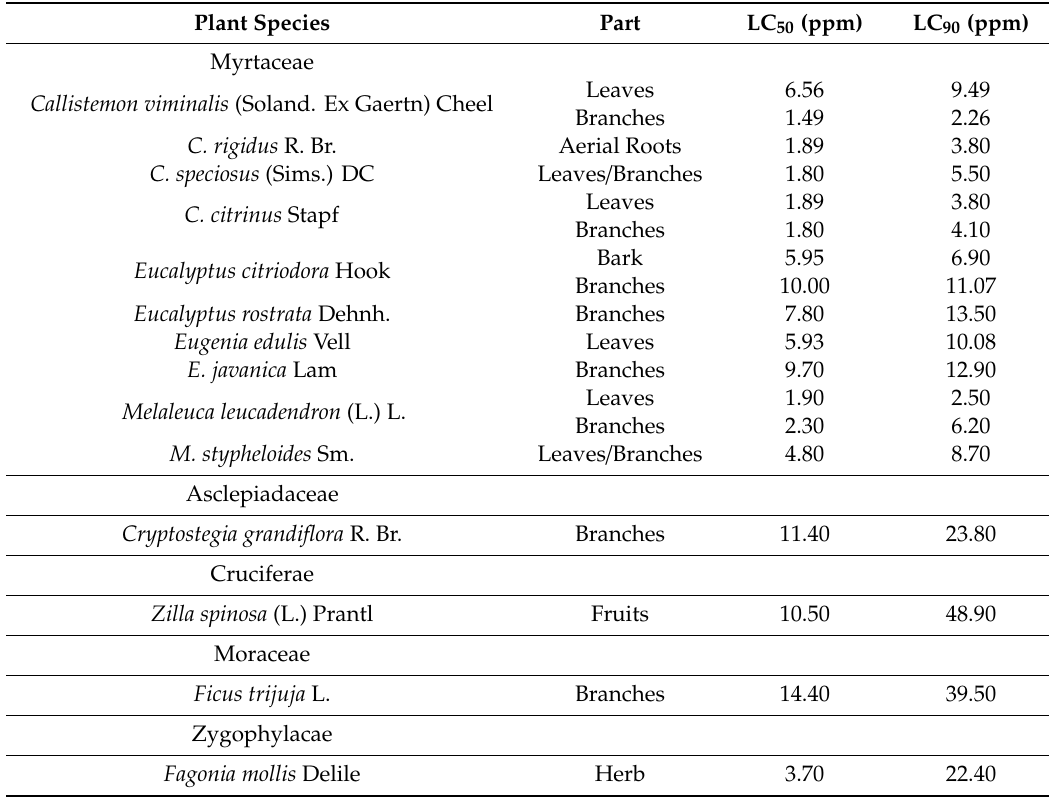
Table 5. Egyptian species with activity against S. mansoni by Yousif et al. [95]. Plant Species Part LC 50 (ppm) LC 90 (ppm)